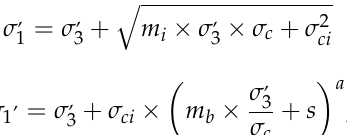
Table 4. Equations for calculation of E m without E i